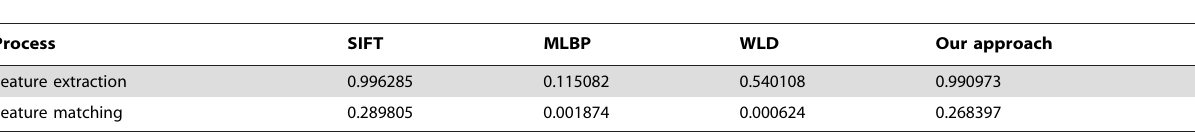
Table 3. The time consumption for different methods (s).